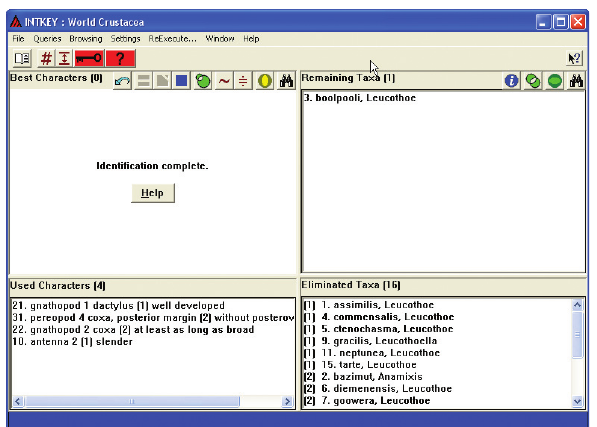
Figure 77. For the second set of taxa the identifi cation is fi nished and another endpoint of the key is reached.